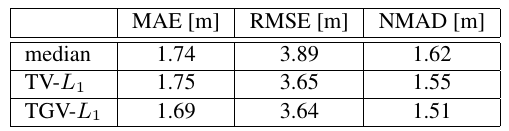
Table 1: London dataset: Accuracy of the fused DSM w.r.t. ground truth obtained by aerial laserscanning